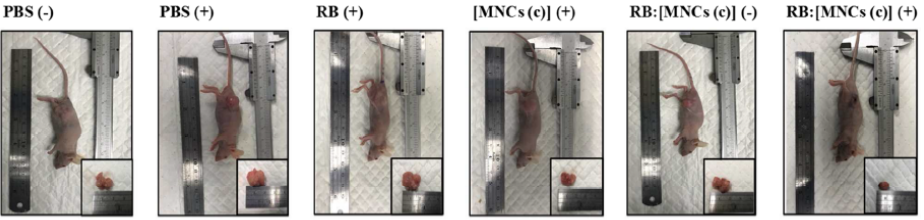
Figure 36. Representative digital images of mouse tumor treated with PBS, RB, MNCs and RB:MNCs (124 µg and 0.25 mg per mouse of RB and Fe 3 O 4 NPs, respectively) with (+) and without ( − ) green laser light irradiation (532 nm, 100 mW/cm 2 , 5 min) for mice after 38 days under different treatment conditions. Reprinted with permission from Yeh et al. [97]. Copyright 2018 American Chemical Society.